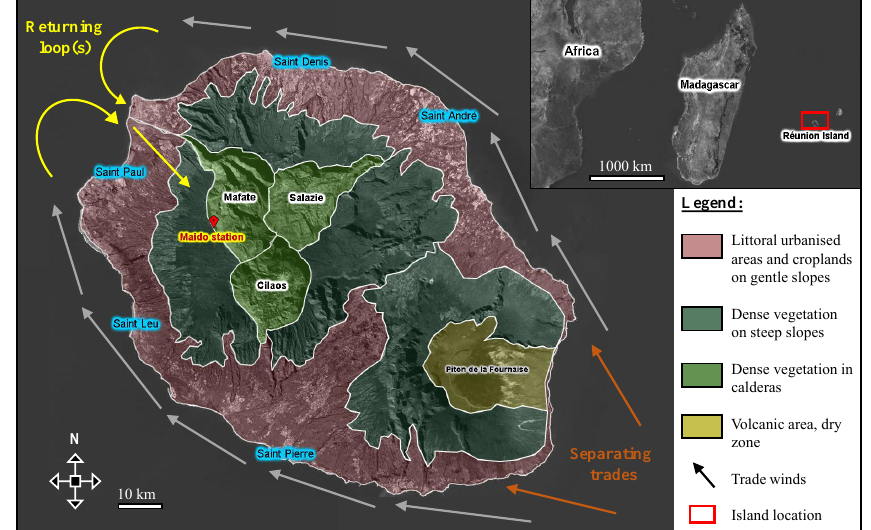
Figure 1. Map of Réunion and its location. Different terrain types are represented as well as a simplification of the local atmospheric dynamic pattern around the